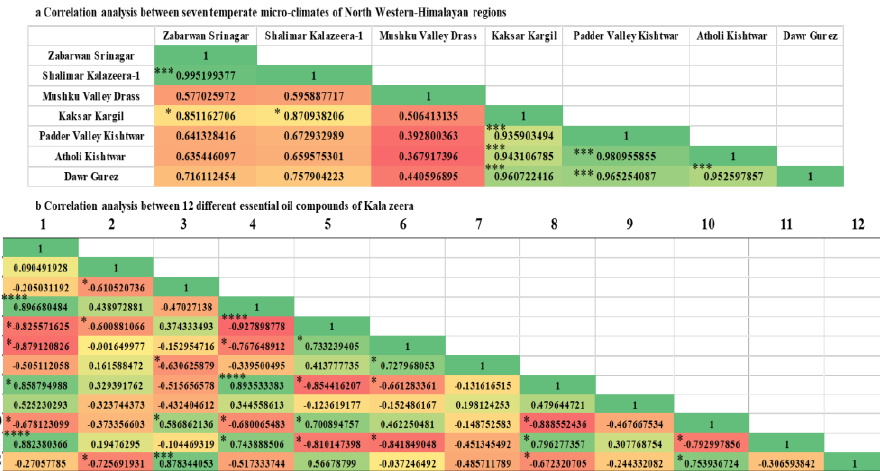
Figure 3. Pearson correlation analysis showing the strength of linear relationship between two compo- nents. ( a ) Correlation analysis between seven temperate micro-climates of Northwestern-Himalayan region, and ( b ) Correlation analysis between 12 different essential oil compounds of Kala zeera. Where